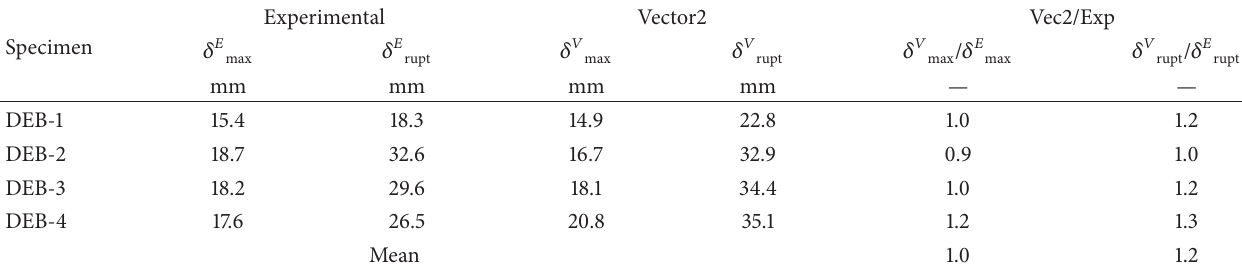
Table 5: The deformation ratio between experimental and Vec2 analysis results.